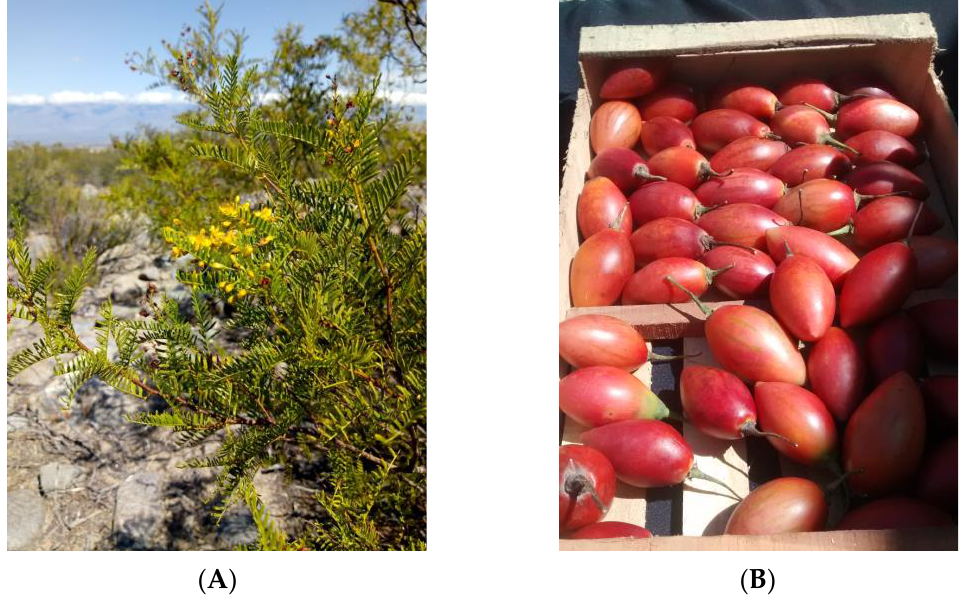
Figure 1. ( A ) Aerial parts of Z. punctata Cav. ( B ) S. betaceum fruits, Photo by F. M. Correa Uriburu.